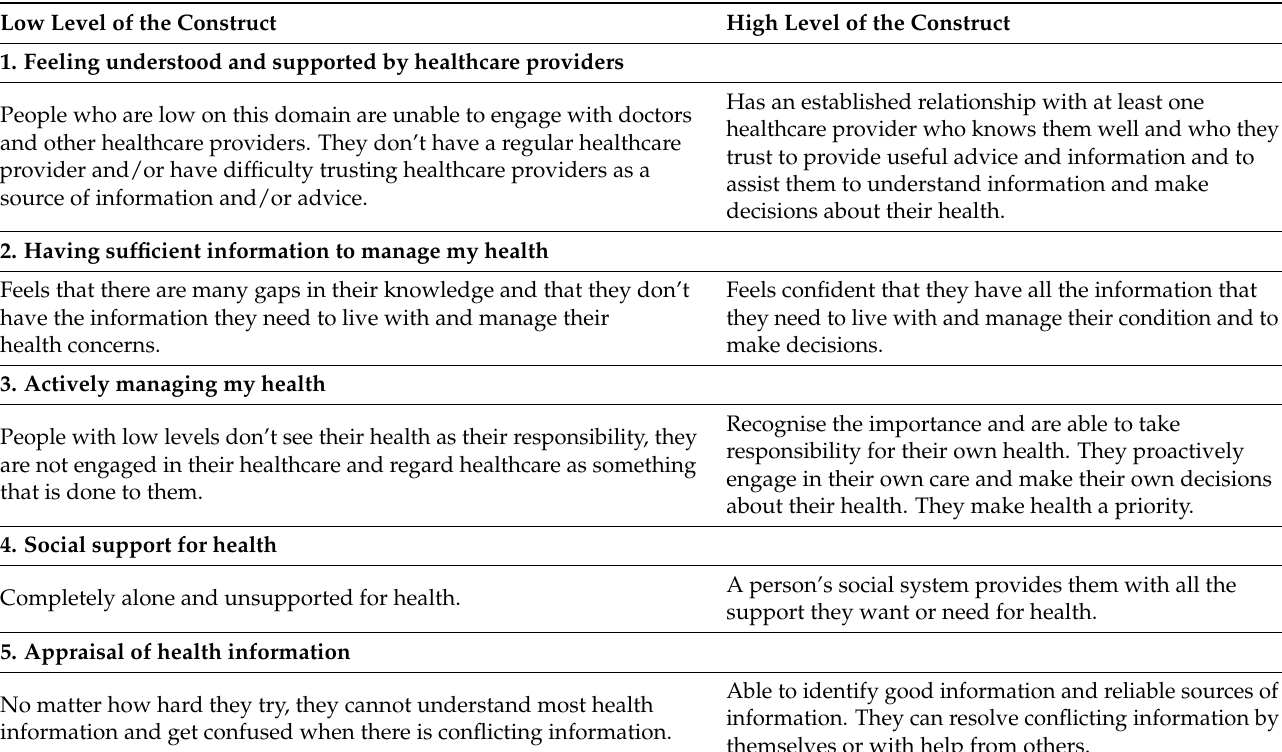
Table 1. Health Literacy Questionnaire (HLQ) scales with high and low descriptors of each construct